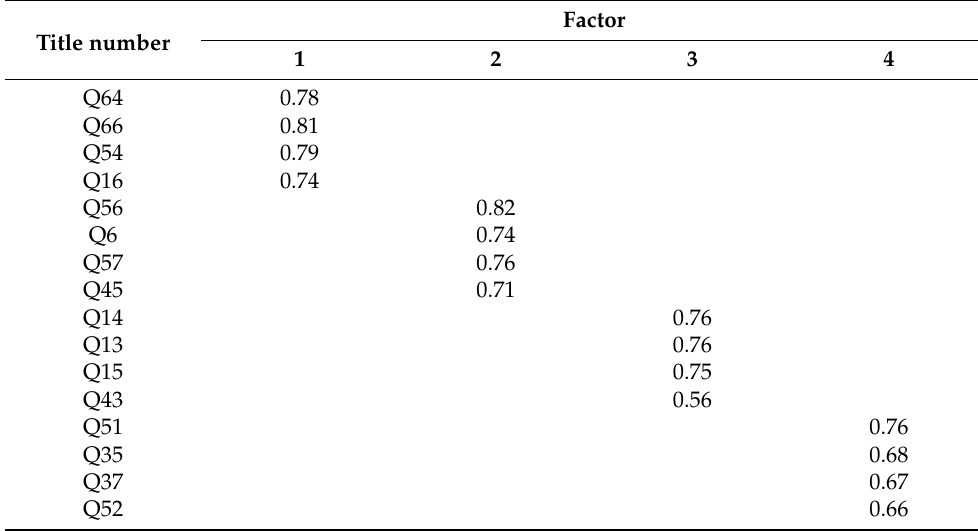
Table 2. Factor structure of the Resilience Scale for Chinese Children.